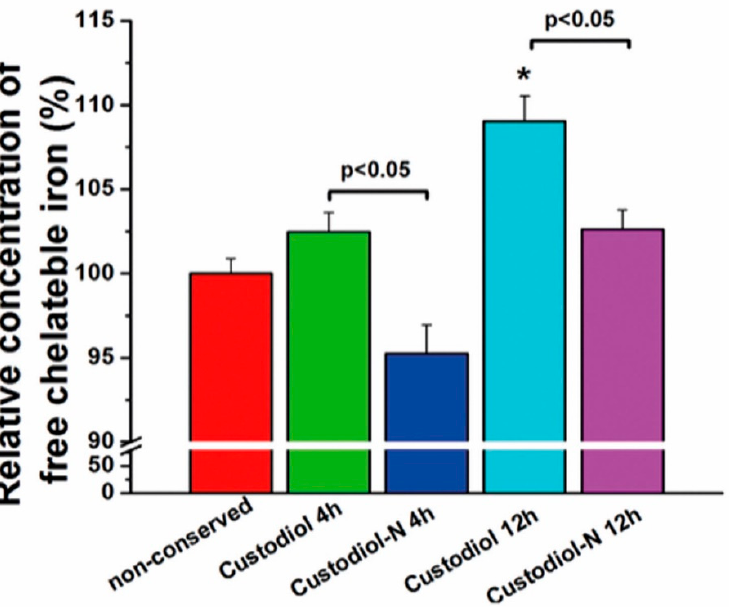
Figure 7. Chelatable iron concentration (Series 3). Chelatable iron concentrations are expressed as relative